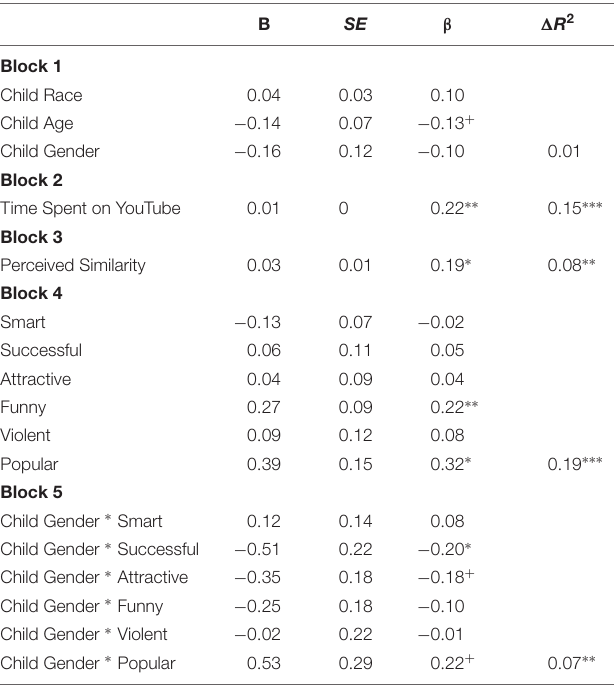
TABLE 7 | Summary of hierarchical regression for attributes predicting parasocial relationships as moderated by child